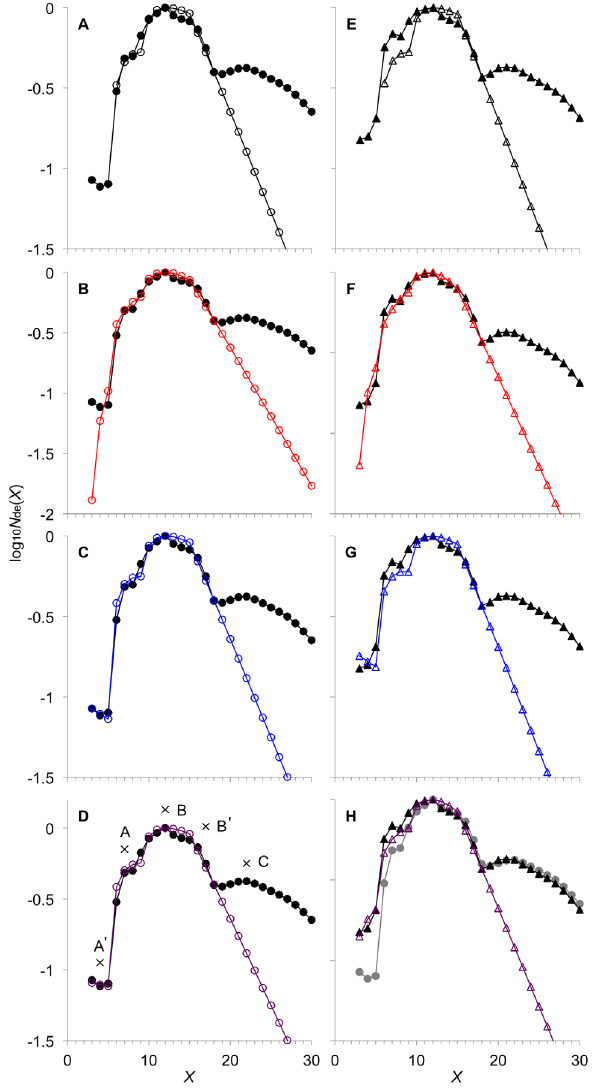
Figure 1. Arabidopsis leaf starch CLD fitted to different combinations of AMY and BAM. N de ( X ) (arbitrary units) from the wild type WT CLD (black filled circles) and the ISA-type DBE mutant defective in the AtISA1 gene Atisa1-1 CLD (black filled triangles) are replotted from ref. [34]. Crosses and letters indicate features in the CLD. Note the letters in bold font indicate the panels, and are not part of the CLD features. ( A ) and ( E ): simulated CLD with AMY – /BAM – fitted to WT CLD and Atisa1-1 CLD, respectively; ( B ) and ( F ): that for AMY – /BAM + ; ( C ) and ( G ): that for AMY + /BAM – ; ( D ) and ( H ): that for AMY + /BAM + . Simulated CLD are shown by different colored shapes corresponding to the different combinations of AMY and BAM. Fitting is to the enzyme set (i) range (3 # X # 18). ( B ) and ( D ) are compressed on the ordinate. The gray filled circles represent WT CLD replotted for comparison with Atisa1-1